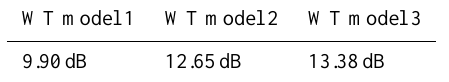
Table 3. Relation (cid:49) between the relative scattering area of the mast and blades for the wind turbine models selected for the simulations.